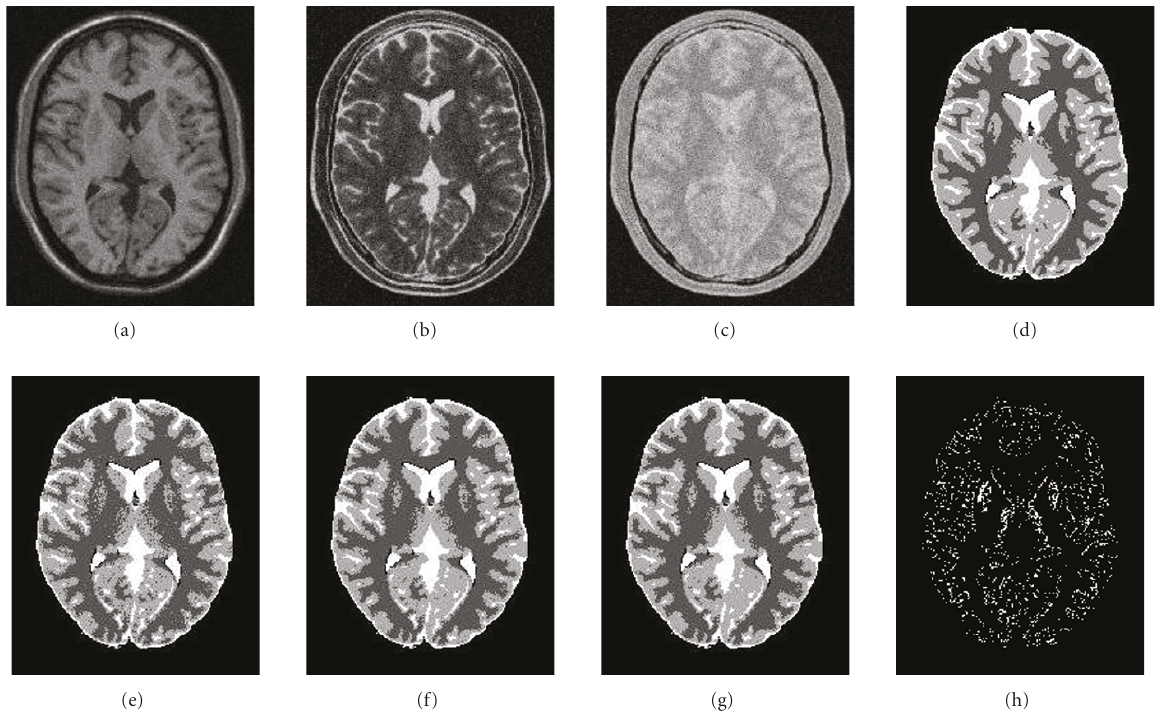
Figure 4: Segmentation result [WM (dark), GM (intermediate brightness), and CSF (bright)] of the proposed algorithm on a typical image of brainweb dataset (slice 80 of the dataset produced by 7% of noise). (a), (b), and (c) T1, T2, and PD images, respectively. (d) Phantom image. (e) FCM result. (f) Direct MC result. (g) Indirect MC result. (h) Error image of direct MC method (white intensity shows the place of error occurrence).